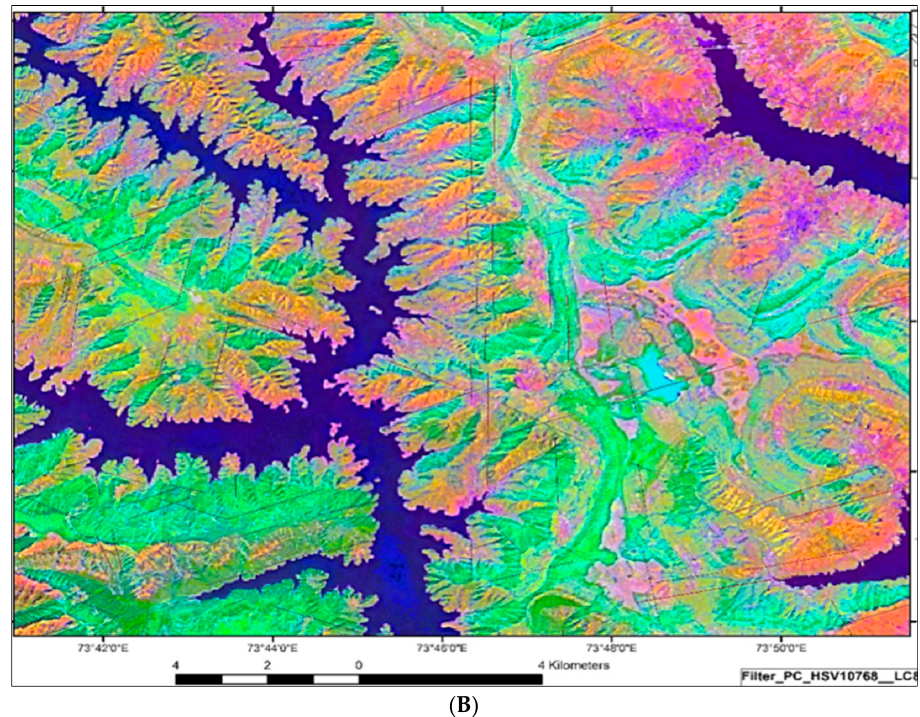
Figure 11. Principal component scene based on Landsat 8 thermal band combination (Bands 10, 7 and 6) merged with Band 8 ( A ), visualizing NS-striking linear features (principal component created in ENVI-software by forward PC rotation and computed by new statistics, ( B ))